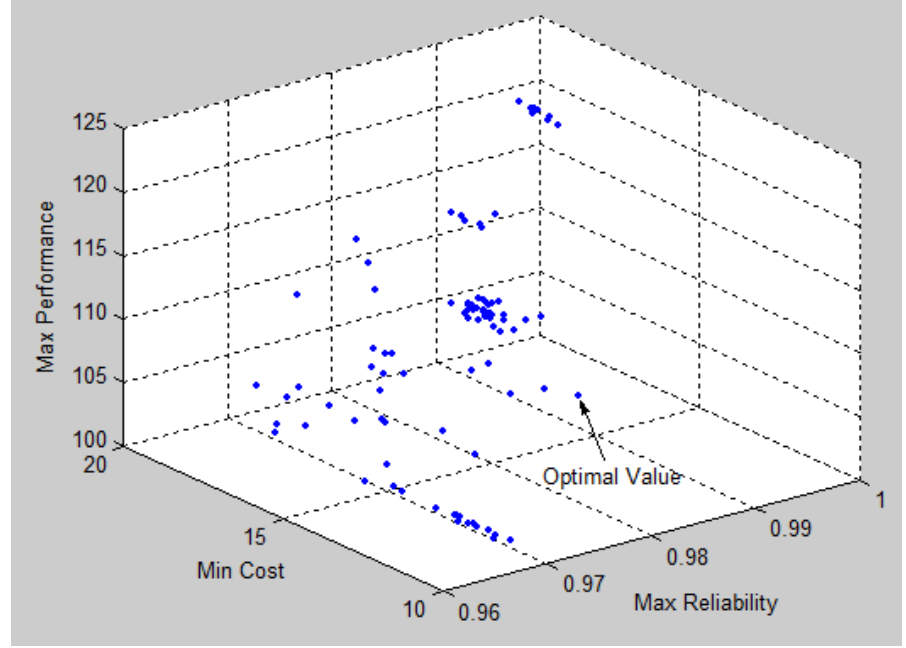
Figure 6. Pareto front of Example 2, multi-objective optimum. Table 7. Comparison between bi- and multi-objective design values, and individually optimized cost. Subsystem